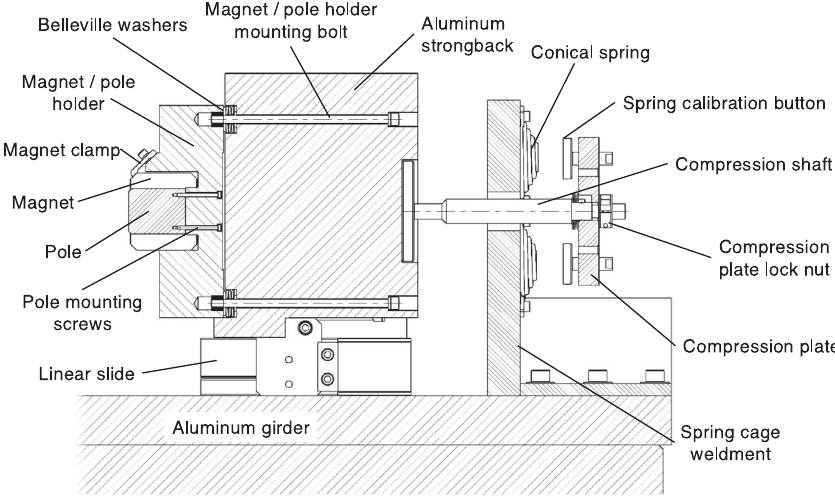
FIG. 3. Cross-sectional view of the undulator strongback, magnet/pole holder, and spring unit.